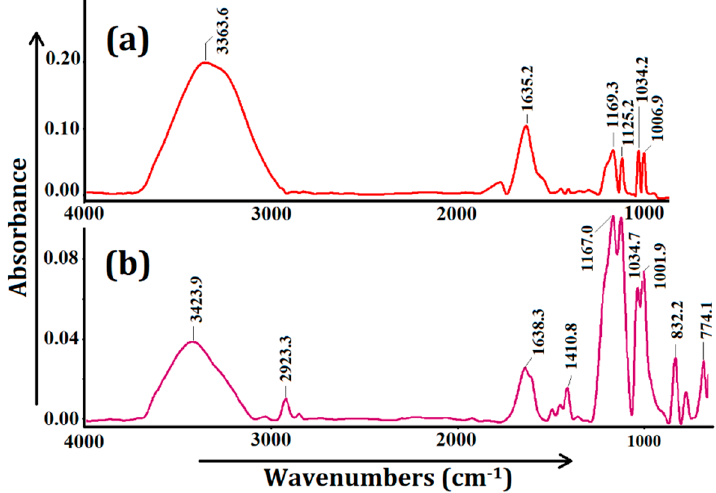
Figure 8. FTIR Spectra of ( a ) Dowex-50 resin and ( b ) CR-AgNCs catalyst.